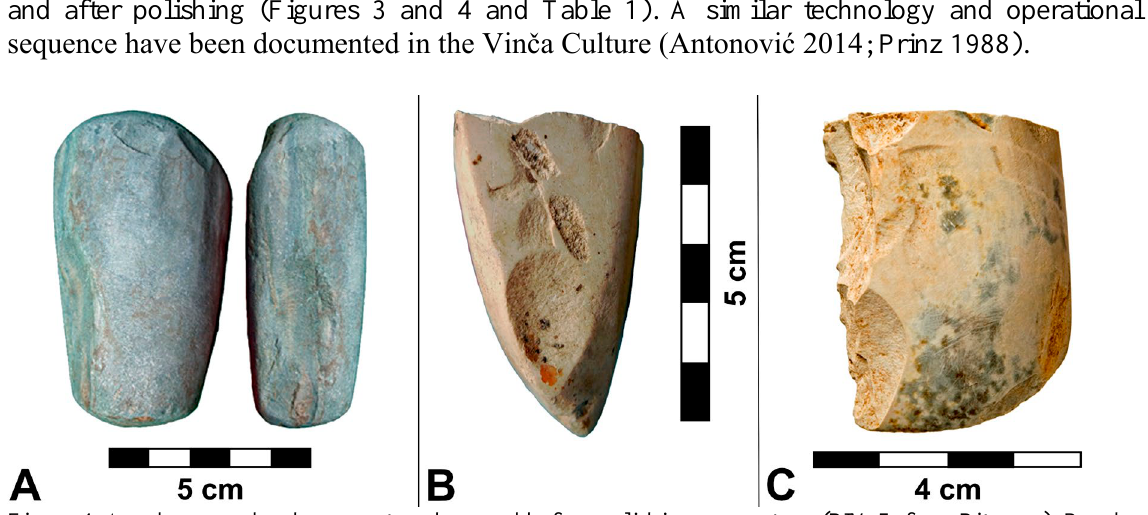
Figure 4. A: adze reused as hammerstone knapped before polishing, greenstone (PIV-5, from Pitvaros); B: adze blade fragment knapped before polishing, “white stone” (GOR-901, from Gorzsa); C: adze blade fragment knapped after polishing, “white stone” (PIV-10, from